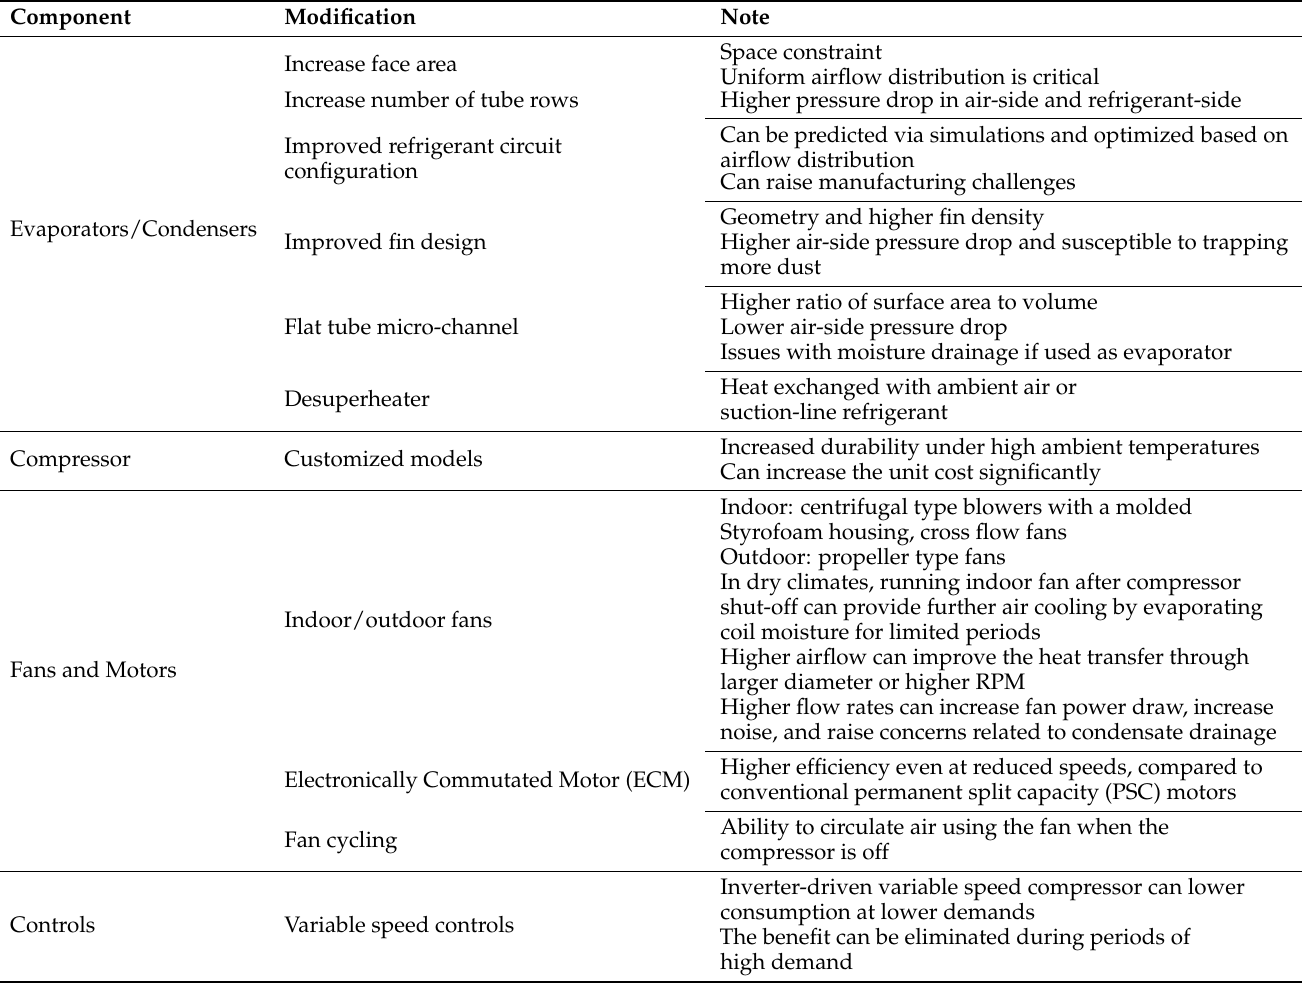
Table 4. Possible design modifications of residential air conditioners for high ambient condi- tions (46 ◦ C ).